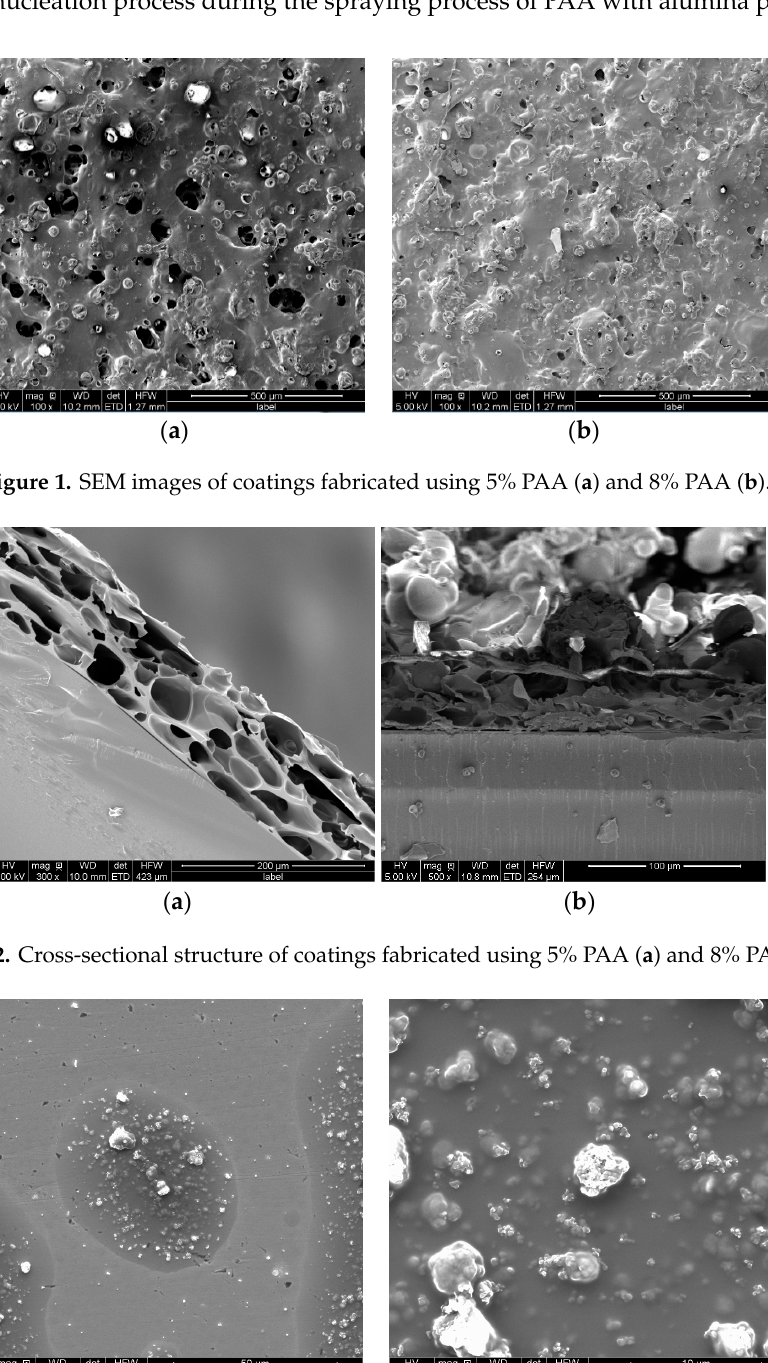
Figure 3. ( a ) A single polyimide droplet with 10% alumina and ( b ) a partial enlarged view of the droplet.